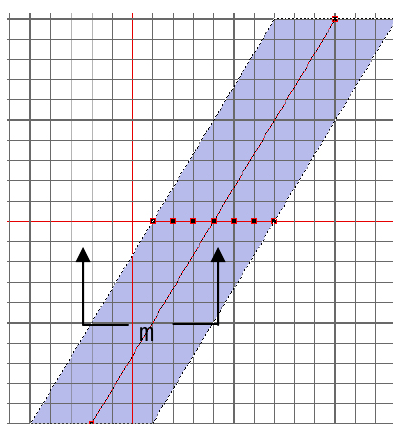
Figure 2. Narrow-band of level